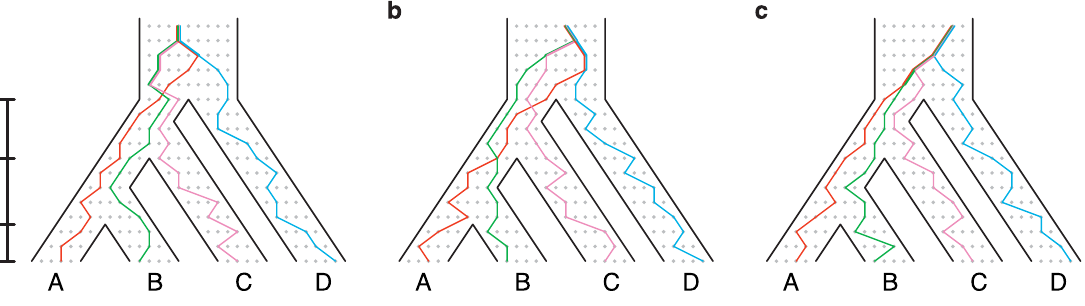
Figure 1. Anomalous Gene Trees for Four Taxa Colored lines represent gene lineages that trace back to a common ancestor along the branches of a species tree with topology (((AB)C)D). The figure illustrates how a gene tree can have a higher probability of having a symmetric topology, in this case ((AD)(BC)), than of having the topology that matches the species tree. If the internal branches of the species tree— x and y —are short so that coalescences occur deep in the tree, the two sequences of coalescences that produce a given symmetric gene tree topology together have higher probability than the single sequence that produces the topology that matches the species tree. (a) and (b) Two coalescence sequences leading to gene tree topology ((AD)(BC)). In (a), the lineages from B and C coalesce more recently than those from A and D, and in (b), the reverse is true. (c) The single sequence of coalescences leading to gene tree topology (((AB)C)D). DOI: 10.1371/journal.pgen.0020068.g001